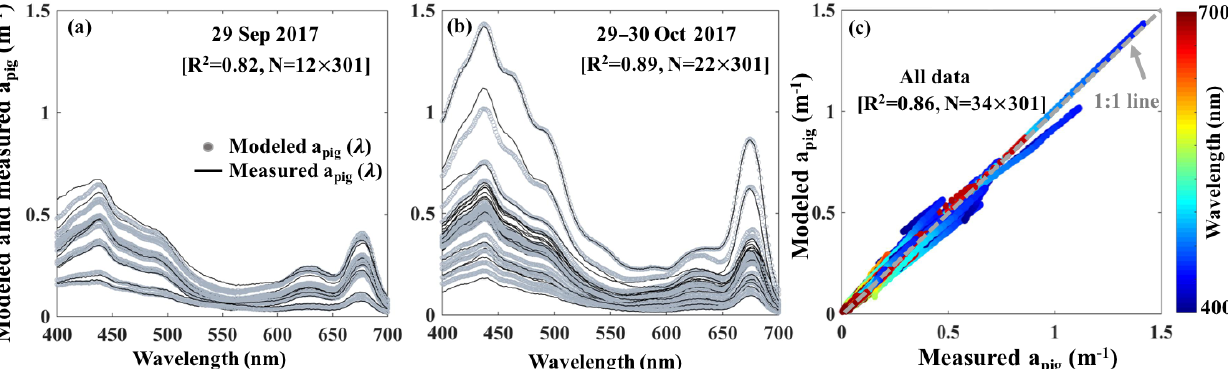
Figure 12. Spectrophotometrically measured and multiple-regression fitted a pig (λ) spectra acquired on (a) 29 September and (b) 29–30 Oc- tober 2017 in GB. Gray and black lines represent modeled and measured results, respectively. (c) Comparison between modeled and spec- trophotometrically measured a pig (λ) for all data with color representing wavelength.